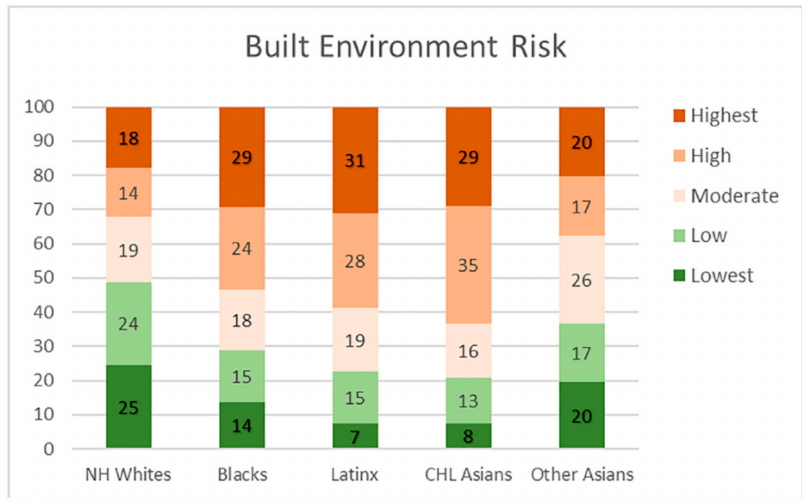
Figure 8. Ethnoracial distribution by neighborhood built environment vulnerability.